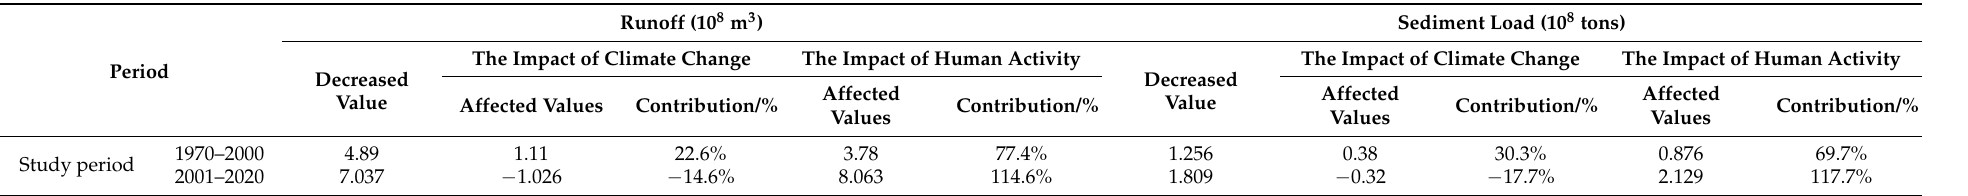
Table 4. Contribution rate of climate change and human activities in the Wuding River basin during the study period calculated by the hydrologic